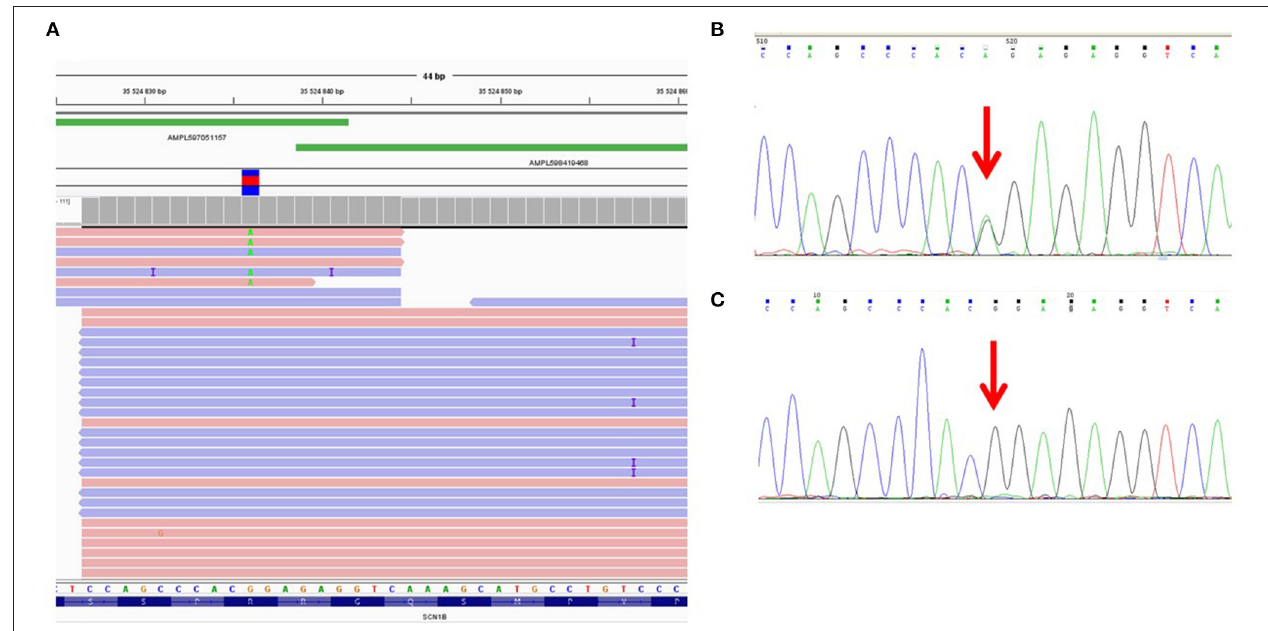
FIGURE 1 | Allelic dropout in the SCN1B gene in DNA sample of proband NRF124. (A) Ion Torrent PGM sequencing results. Genetic variant c.641G > A is detected on only one of two overlapping amplicons. (B) Fragment of the Sanger sequencing chromatogram showing the presence of heterozygous variant c.641G > A in the proband (arrow). (C) Fragment of the Sanger sequencing chromatogram obtained with oligoprimers identical to AmpliSeq.